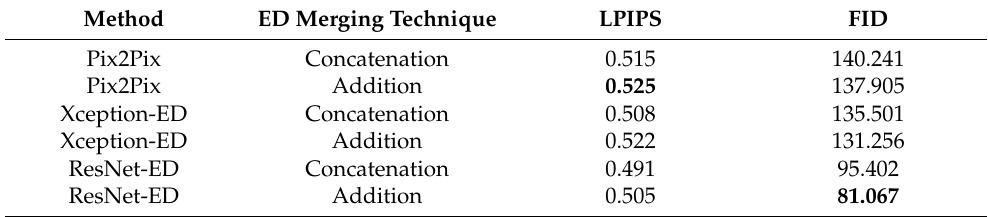
Table 3. Comparison between the proposed GAN models trained on ADE20K indoor subset with 100 semantic labels in terms of LPIPS and FID metrics. Note that the generator and discriminator parameter counts for each model are the same as those values reported in Table